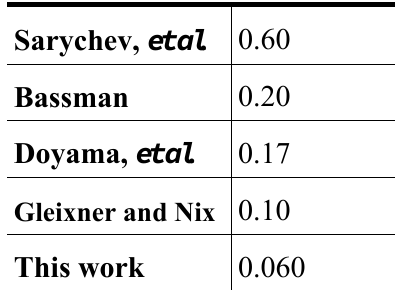
Table 2. Vacancy relaxation factors as reported by